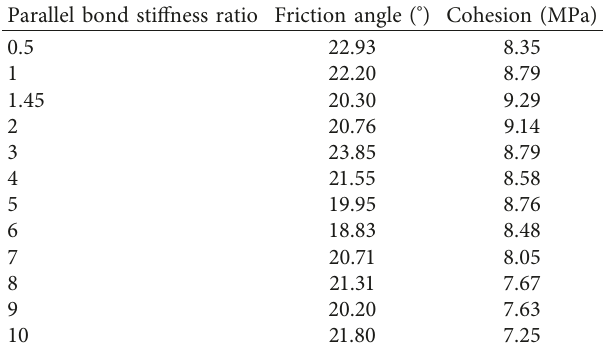
Figure 2: Influence of particle contact stiffness on Table 2: Shear strength parameter values of different parallel bond stiffness ratios.